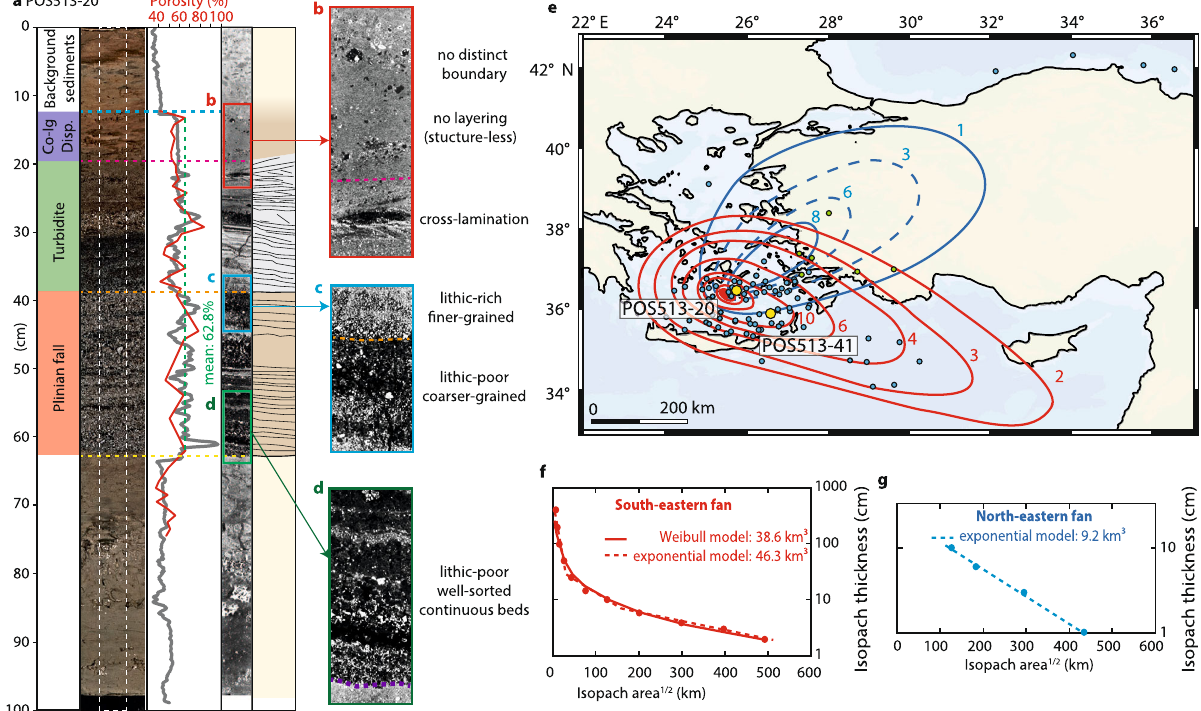
Fig. 1 | Sedimentological analysis of marine gravity core POS513-20. a Photographic scans, porosity measurements, X-ray CT-scan, and stratigraphic interpretation. Co-Ig Disp. refers to the dispersed co-ignimbrite layer. b – d Enlar- gements of key intervals of the X-ray CT-scan showing differences between the deposits ’ subunits. e Isopachmaps (cm) for tephra layer 1 (red; Plinian phase) and